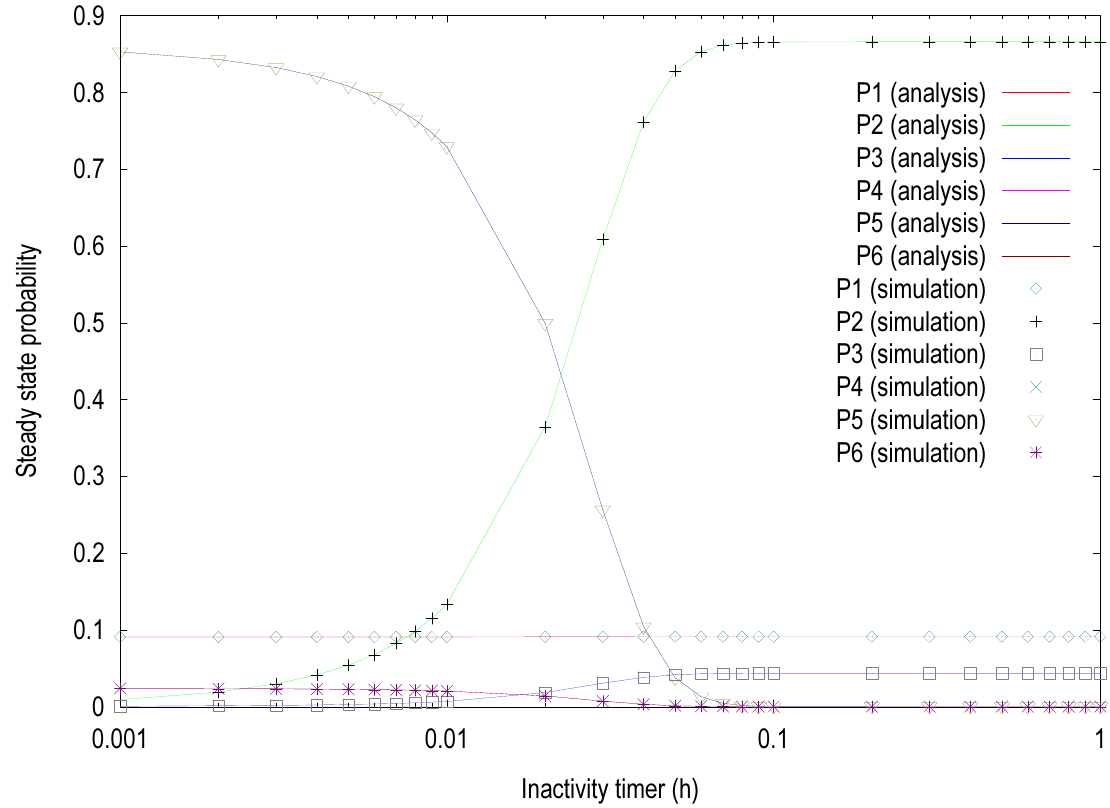
Figure 2. Steady-state probability by varying the session arrival rate (small values of T and T E W